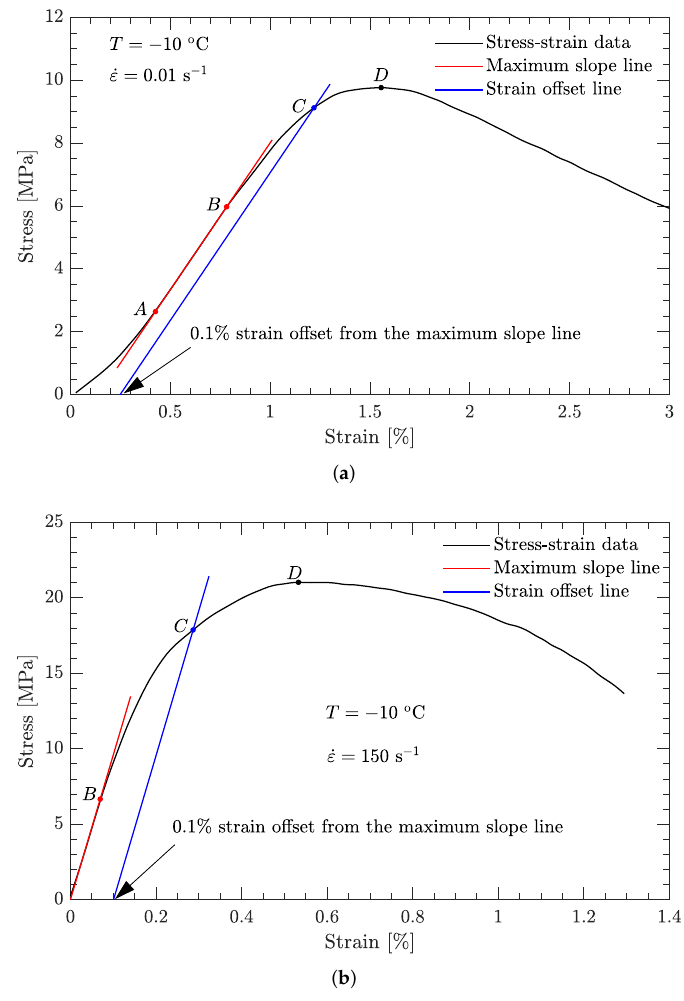
Figure 3. Typical stress–strain curves for both static and dynamic compression. ( a ) Static compression;